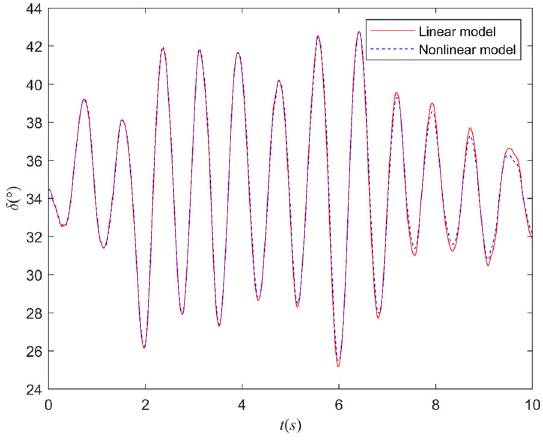
Fig. 7 Comparison of power angle curves between linear and nonlinear models of the system ( σ =